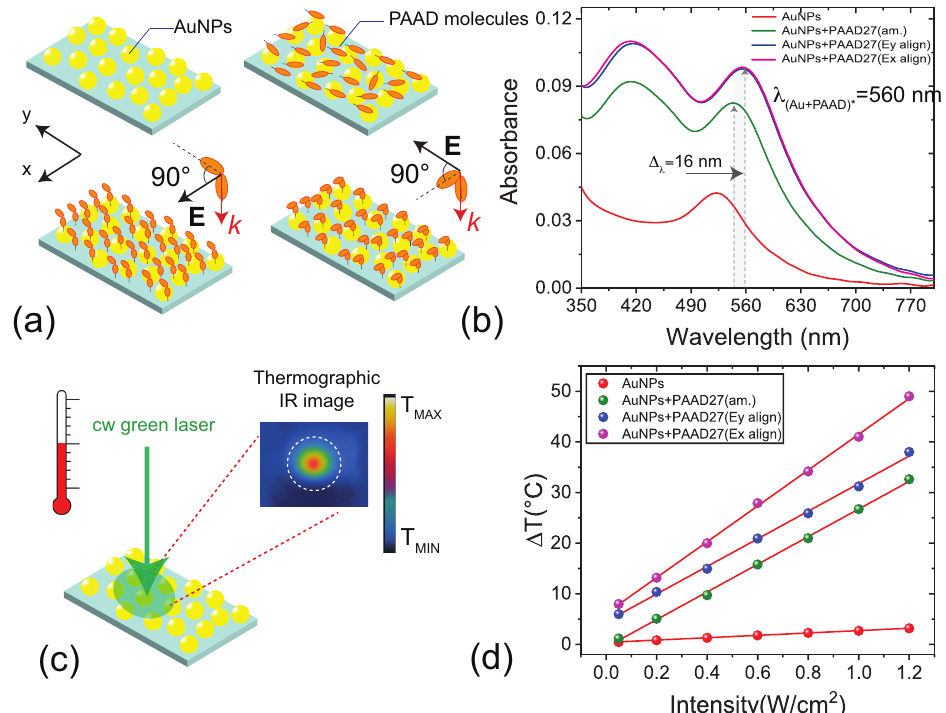
Figure 2. ( a ) Sketch of the AuNPs monolayer on a glass substrate before (top, left) and after the deposition of the PAAD-27 material (top, right); orientation of the PAAD-27 molecules after the exposure to UV radiation for two different polarizations (bottom). ( b ) Absorbance response of the AuNPs monolayer in the air (red curve), after the deposition of the PAAD-27—before (green curve) and after the exposure to polarized UV radiation with different polarizations (blue and magenta curves); ( c ) Sketch of the photothermal measurement. ( d ) Photo-thermal response of the AuNPs monolayer in air and after the deposition and alignment of the